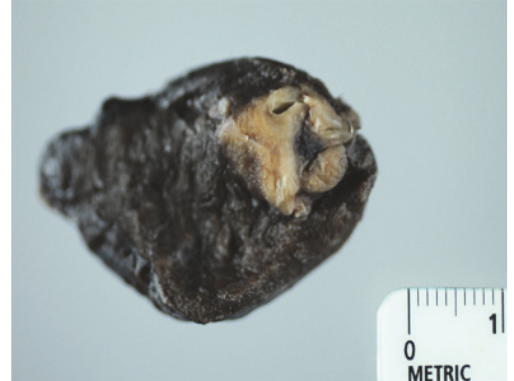
Figure 7: Surgical specimen of one of the resected lung